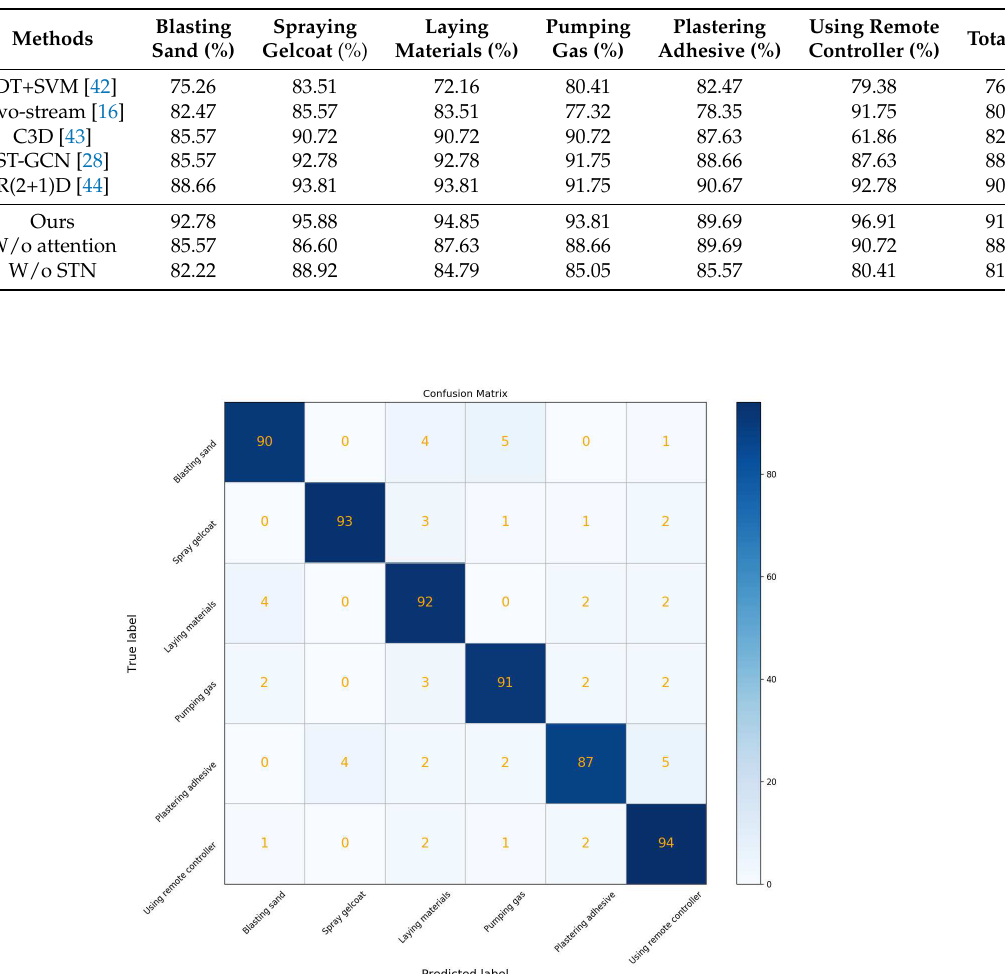
Figure 4. Confusion matrix of the results of our proposed action recognition